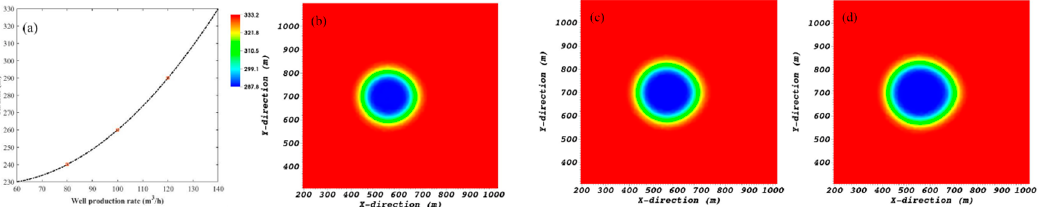
Figure 10. Temperature distribution nephograms of direct geothermal district heating systems (DGDHSs) with different production rates in the 50th year: ( a ) radius of cold water thermal front; ( b ) production rate of 80 m 3 /h; ( c ) production rate of 100 m 3 /h; ( d ) production rate of 120 m 3 /h.